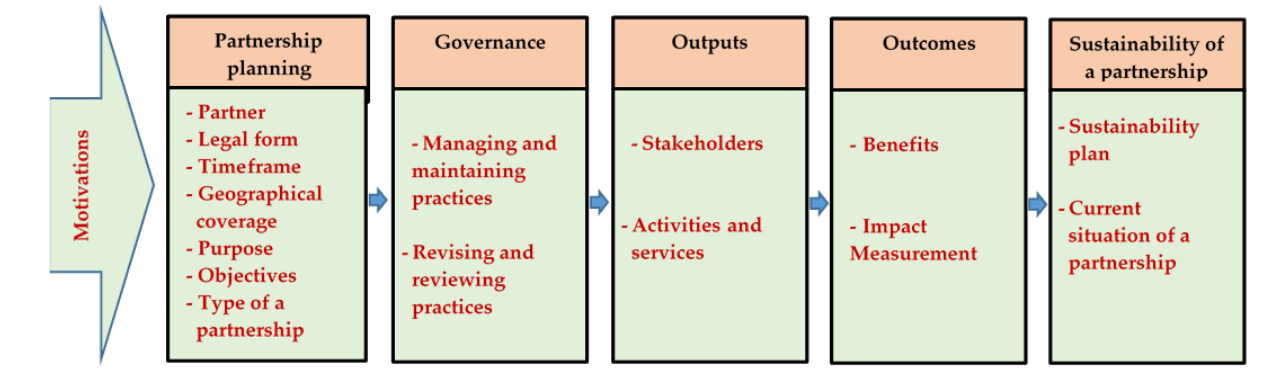
Figure 1. Conceptual framework of the study.